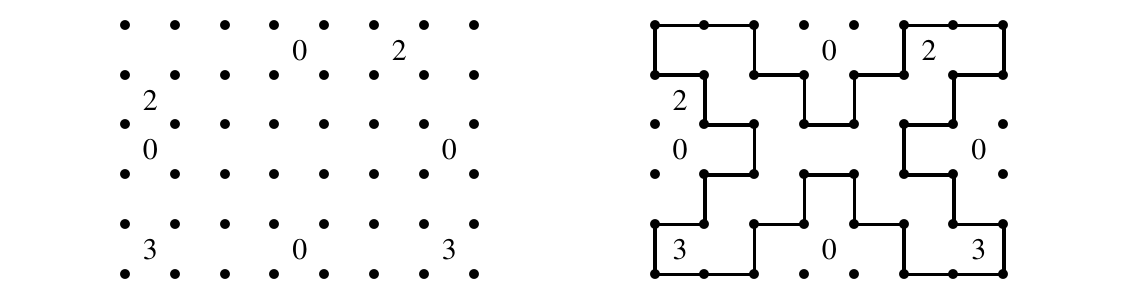
Figure 2. An instance of Slitherlink and its